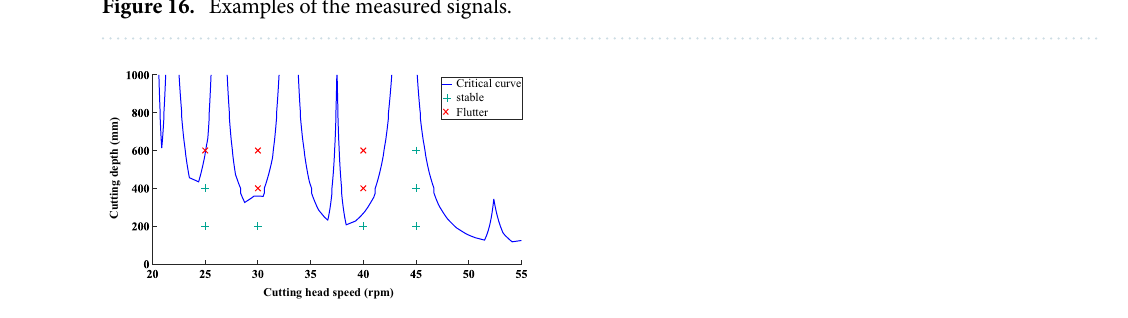
Figure 16. Examples of the measured signals.